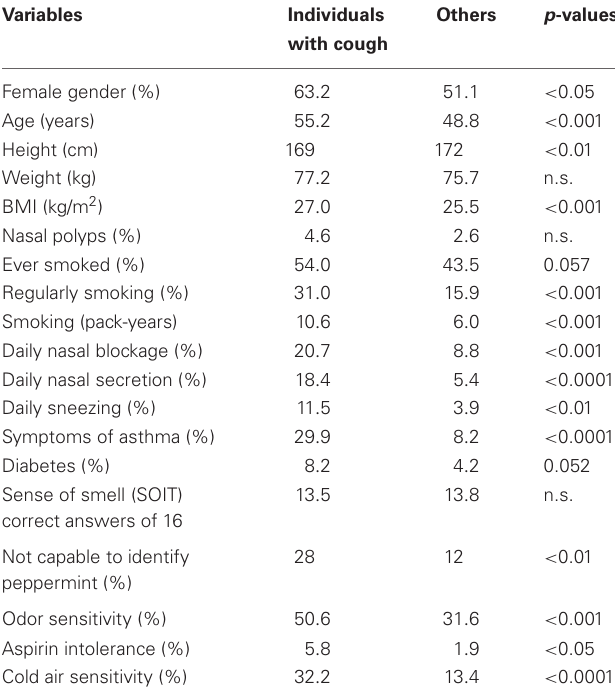
Table 1 | Anthropometric and clinical characteristics, as well as respiratory questionnaire results of individuals with daily or frequent symptoms of cough ( n = 87) compared with others ( n = 1300) in a randomly, age- and gender-stratified, selected population-based study of